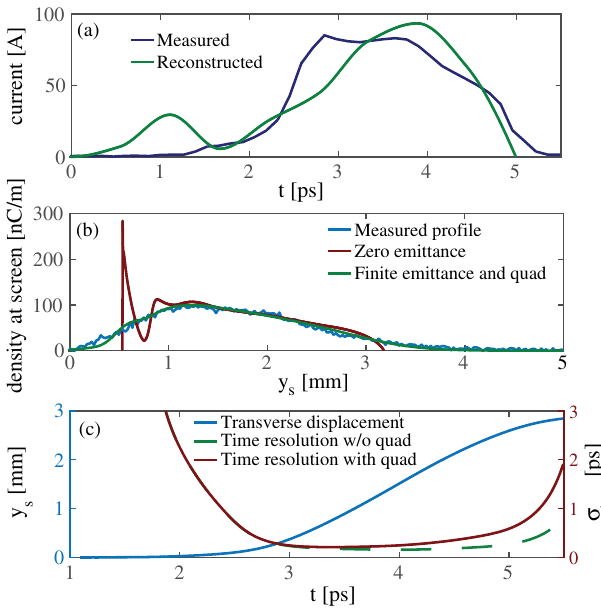
FIG. 4. (a) Temporal profile measured with the TDS (dashed). Temporal profile reconstructed from the passively streaked beam (solid). (b) Measured and reconstructed transverse profiles at the screen. (c) Left axis: transverse displacement at the screen calculated with Eq. (2) with offset Δ y ¼ 0 . 89 mm (blue). Right axis: temporal resolution without defocusing (dashed) and with defocusing (red) of the passive streaker against the longitudinal coordinate inside the